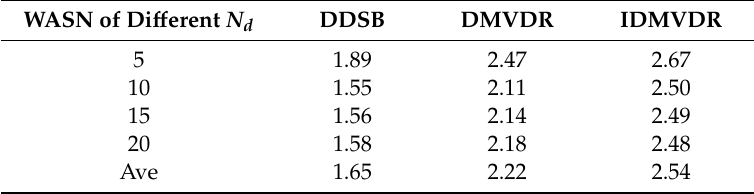
Table 7. The noise reduction performance of di ff erent N d in terms of